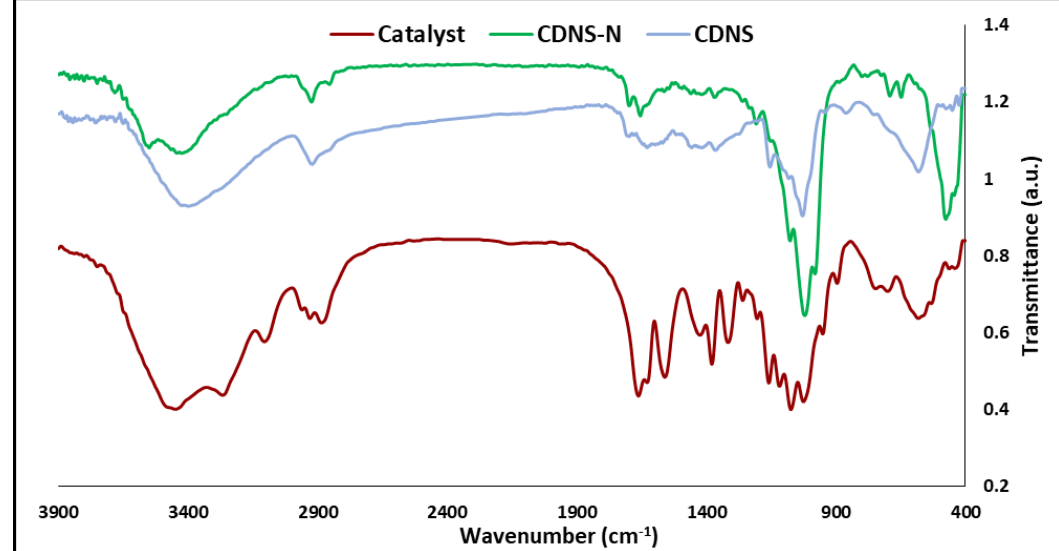
Figure 4. FTIR spectra of pristine CDNS, CDNS-N, and catalyst.